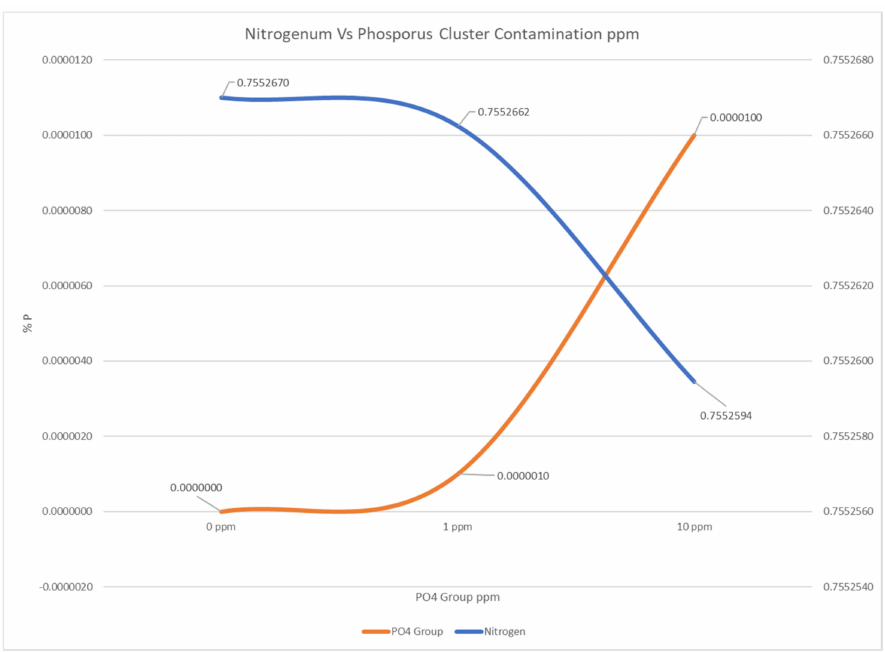
Figure 20. N vs. P cluster contamination 0–10